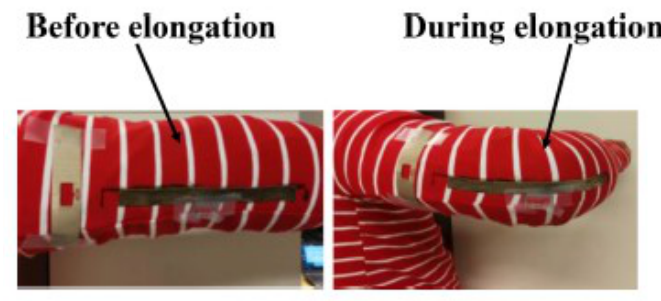
Figure 20. Implemented circuit of the strain sensor on a T-shirt